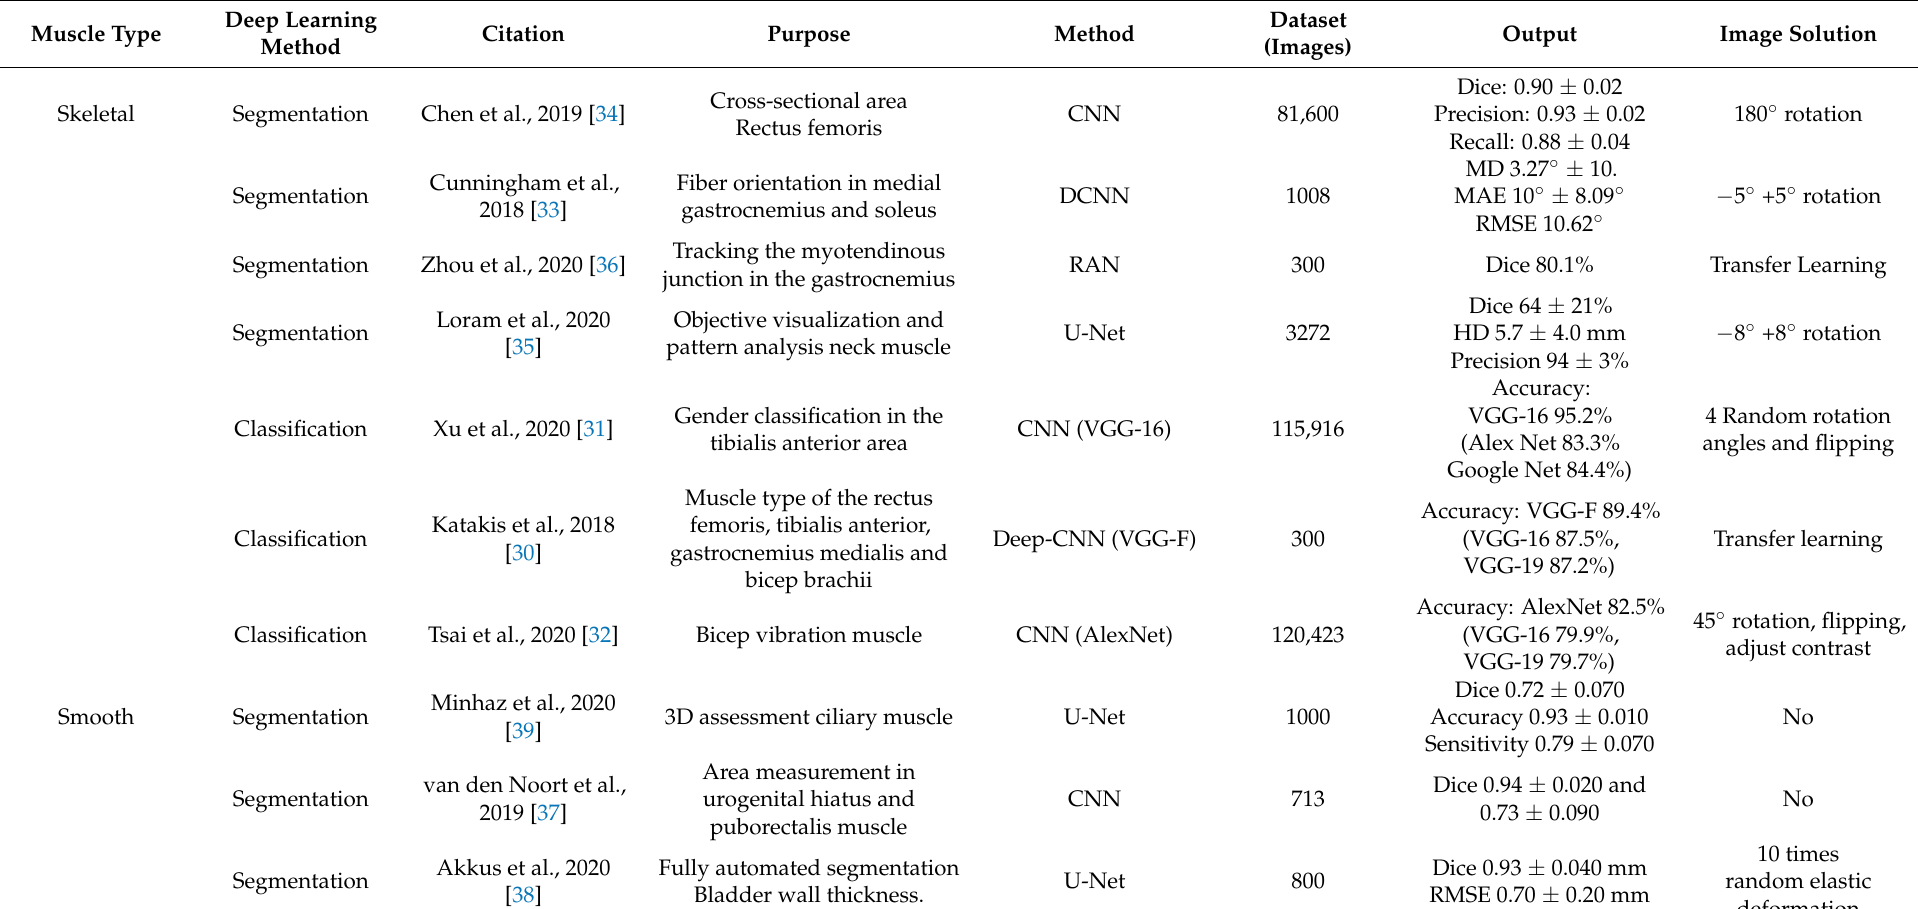
Table 1. Deep learning approaches with image solution strategies to handle skeletal and smooth muscle ultrasound image problems. (CNN: Convolutional Neural Network, DCNN: Deconvolutional Neural Network, RAN: Region Adaptive Network, Deep-CNN: Deep Convolutional Neural Network, MD: Mean Difference, MAE: Mean Absolute Error, RMSE: Root Mean Square Error, HD: Hausdorff